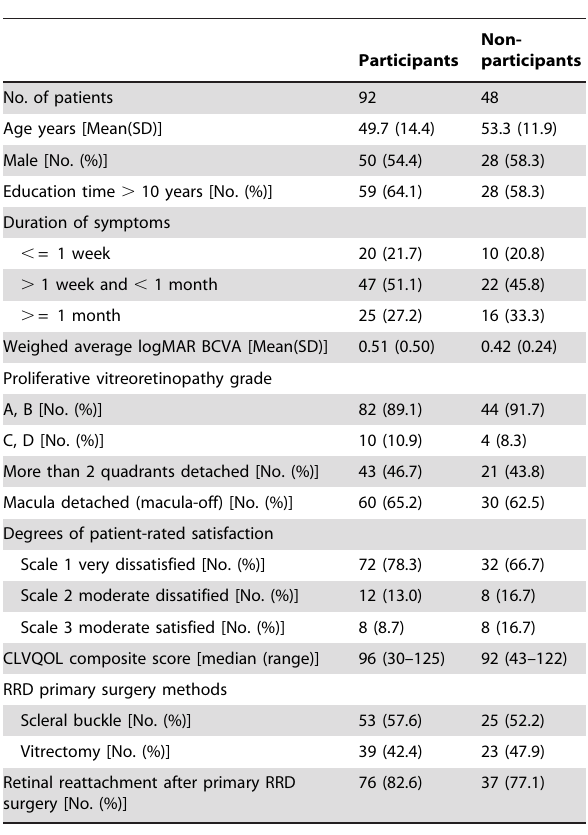
Table 1. Preoperative socieodemographic, clinical, CLVQOL and self-rated satisfaction data, and primary surgery data of 140 eligible RRD